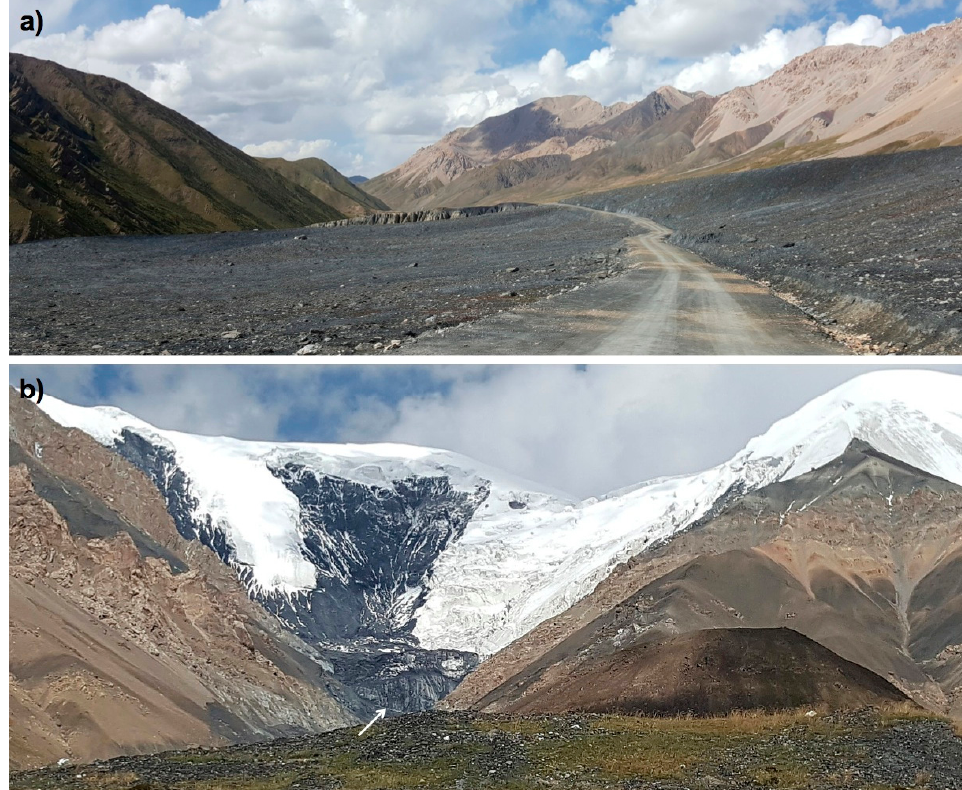
Figure A1. Two images from the deposit taken by Brandon G. Butler on 12 September 2016. ( a ) A view to the north showing the avalanche deposit to the left and right of the reconstructed road crossing it. Image source: [27]. ( b ) A view to the east showing the advancing glacier (the white arrow marks its front), about 3 weeks before its next collapse. Some grass is visible on the deposit of the previous collapse in the foreground. The dark rock slope in the background (to the left of the image center) is the now huge rock outcrop RO-B. Image source: [27].